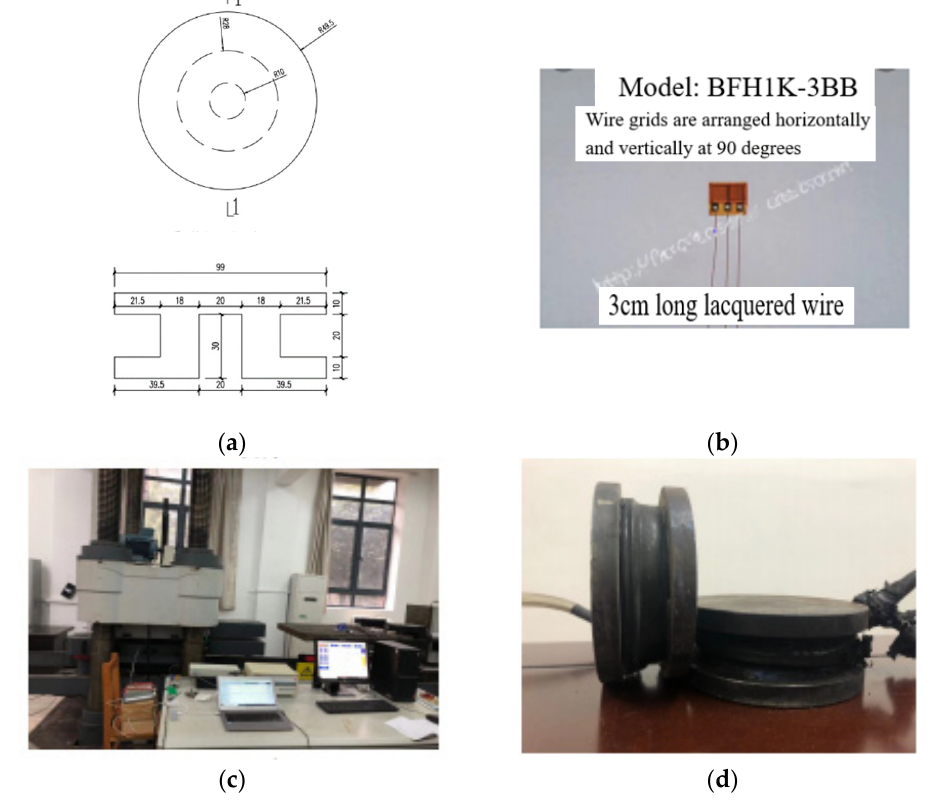
Figure 5. Sensor development process. ( a ) Sensor size ( b ) Strain gauges ( c ) Commissioning of sensors ( d ) Physical sensor